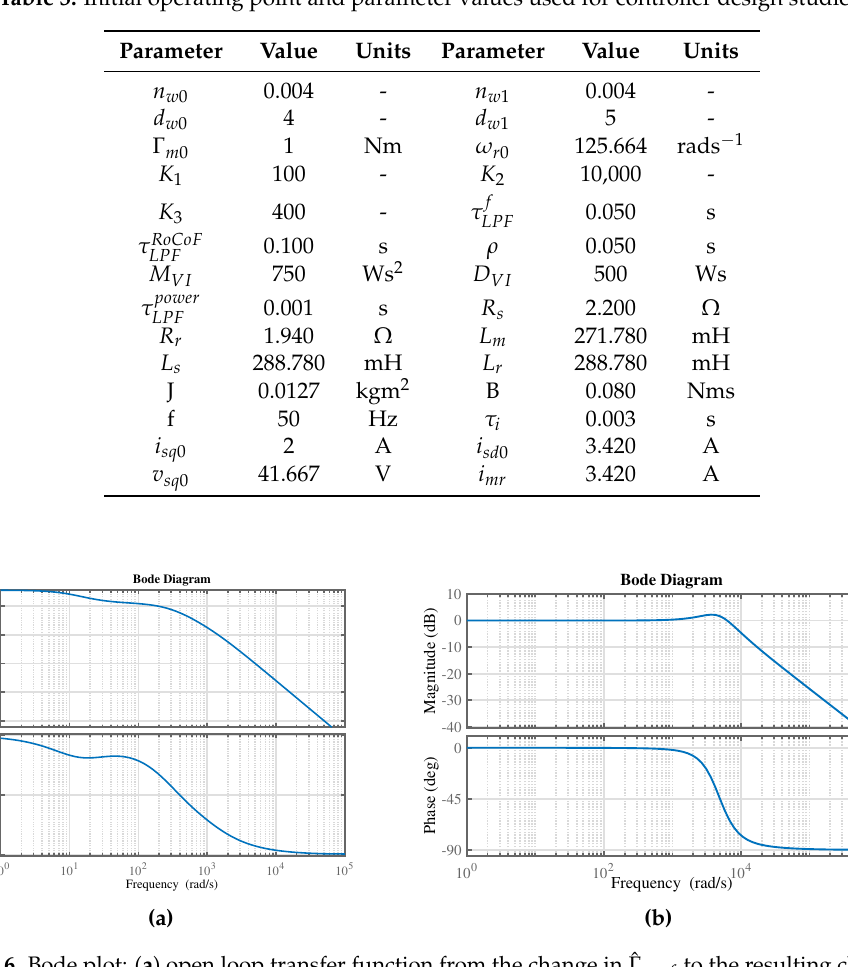
Figure 6. Bode plot: ( a ) open loop transfer function from the change in ˆ Γ e , ref to the resulting change in measured DC link power ˆ P DC ; ( b ) closed loop transfer function from a change in ˆ P ref to the resulting LPF change in DC power ˆ P DC LPF